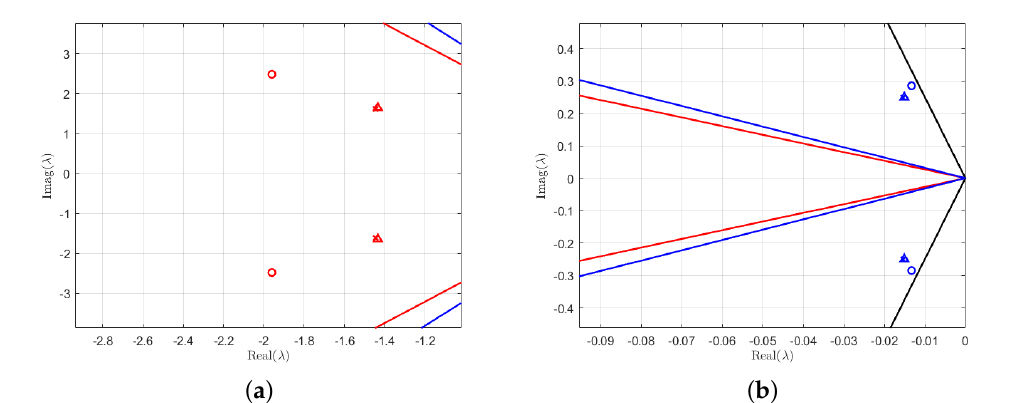
Figure 9. Eigenvalues of short period ( a ) and phugoid ( b ) for the two-surface testbed (triangles), three-surface testbed (circles) and three-surface with reassigned dynamics (crosses) via Scheme B. Lines represent limits for Level 1 flying qualities (black lines: phugoid, blue lines: Category B short period, red lines: Category A short